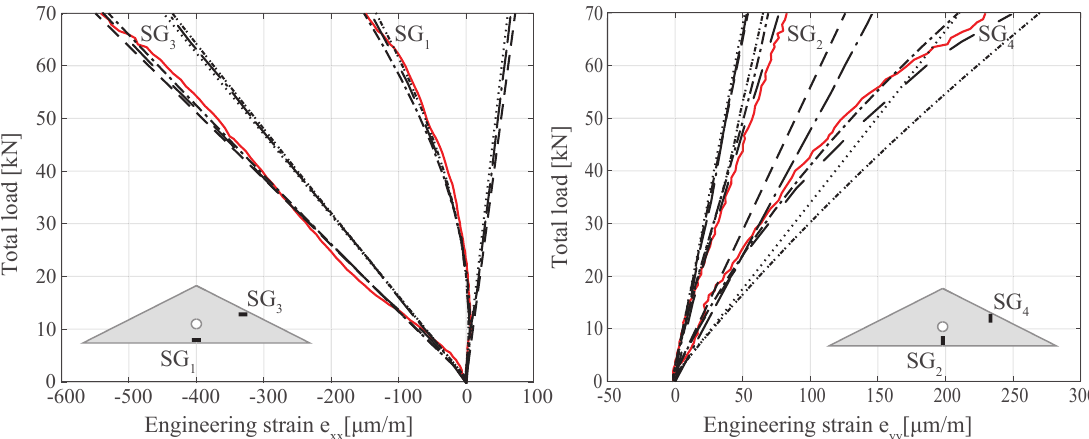
Figure 19. Comparison of experimental (in red) and numerically obtained strain results. Engineering strain is used as it is the output obtained from strain gauge measurements. In addition, as the plates themselves undergo only small deformations, in the numerical results, the engineering strains were found to be equal to the logarithmic strain values. For the numerically obtained results, the graph legend refers to Figure